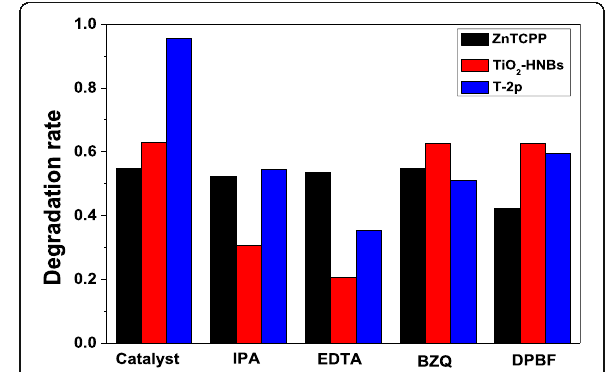
Fig. 10 Cyclic voltammetry analysis of 1.0 × 10 − 3 mol dm − 3 of ZnTCP and T-2p on Pt in 0.1 mol dm − 3 TBAP/DMF vs. SCE. Scan rate: 0.1 V s − 1